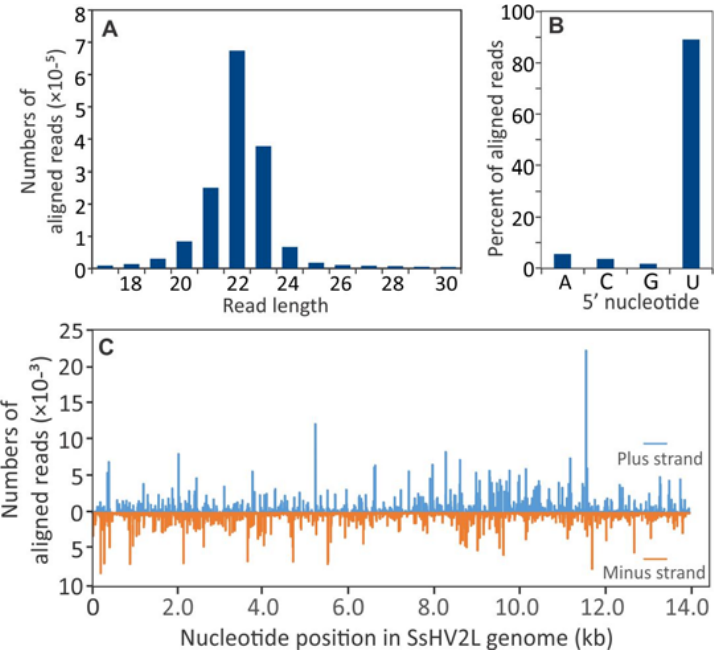
Figure 2. Size distribution of small RNA sequences that aligned to the Sclerotinia sclerotiorum hypovirus 2 L (SsHV2L) genome sequence. ( A ) Size distribution and ( B ) frequency of 5’ terminal nucleotides of small RNAs that aligned to the SsHV2L genome. ( C ) Distribution of small RNA reads that aligned to the SsHV2L genome. Bars above zero indicate alignment to the positive strand, and bars below zero indicate alignment to the negative strand.